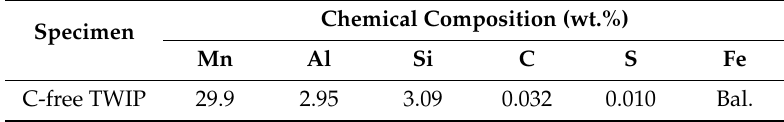
Table 1. Actual chemical composition of C-free Fe-30Mn-3Al-3Si TWIP steel. Chemical Composition Specimen